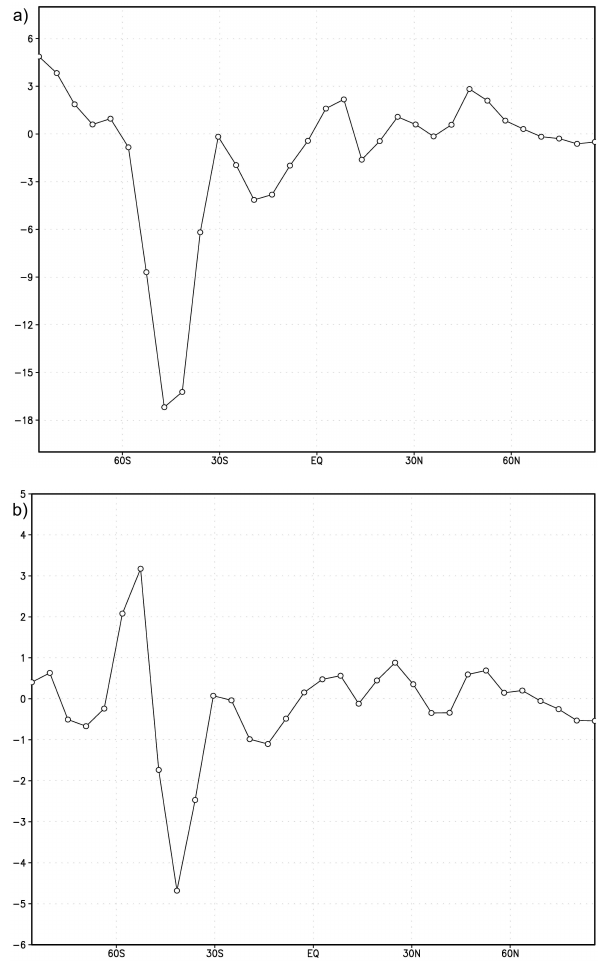
Fig. 6. (a) Zonally averaged difference between the 1000ppm CO 2 and 100ppm CO 2 runs for the mean squared velocity (in m 2 s − 2 ) at the sigma level closest to surface. (b) Same as (a), but the difference between the 1000ppm CO 2 and 350ppm CO 2 runs is